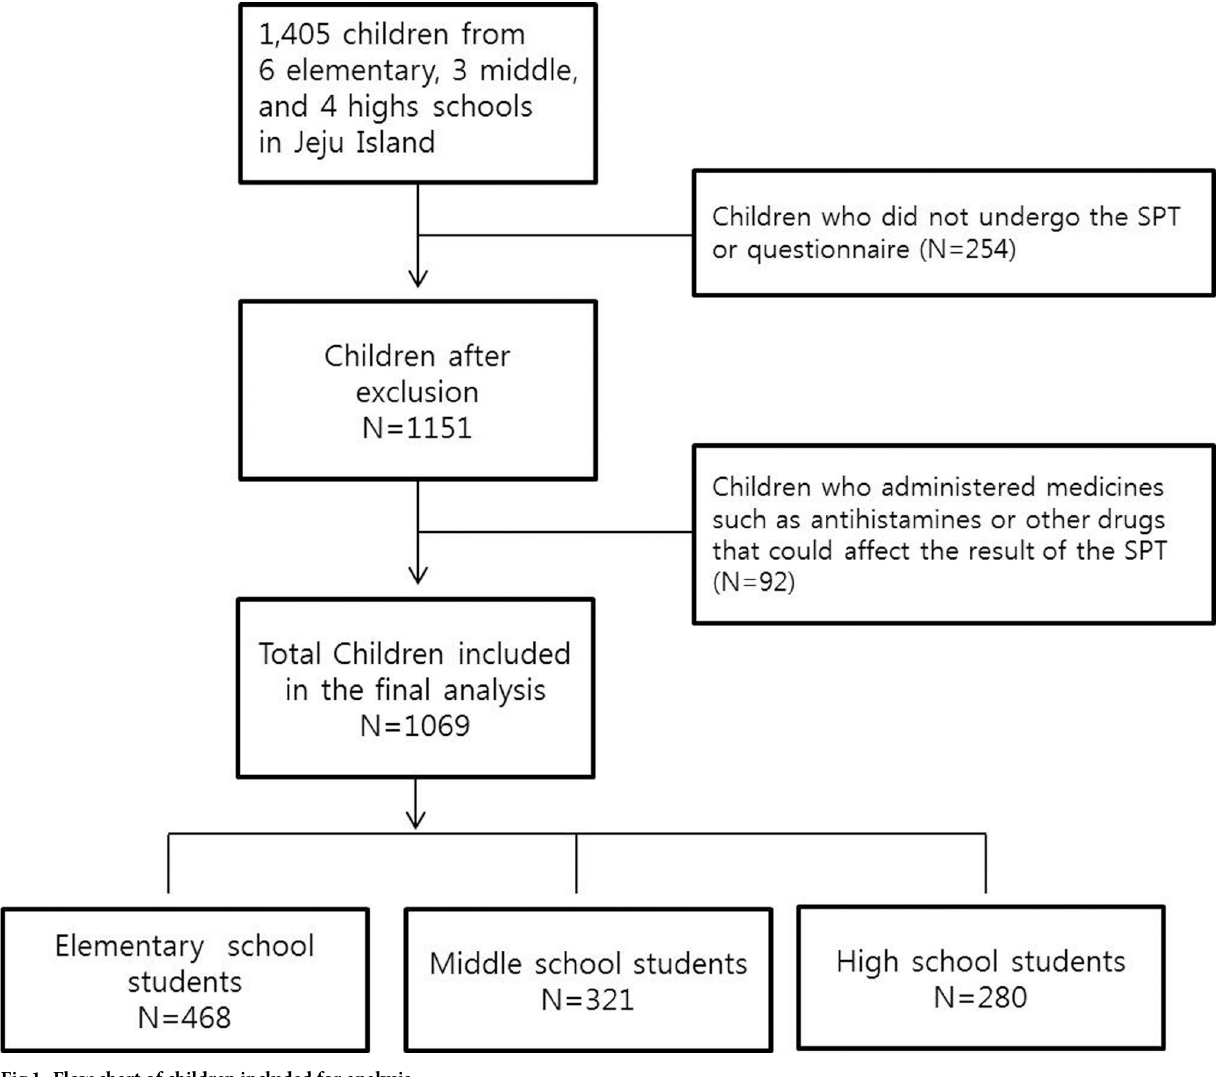
Fig 1. Flow chart of children included for